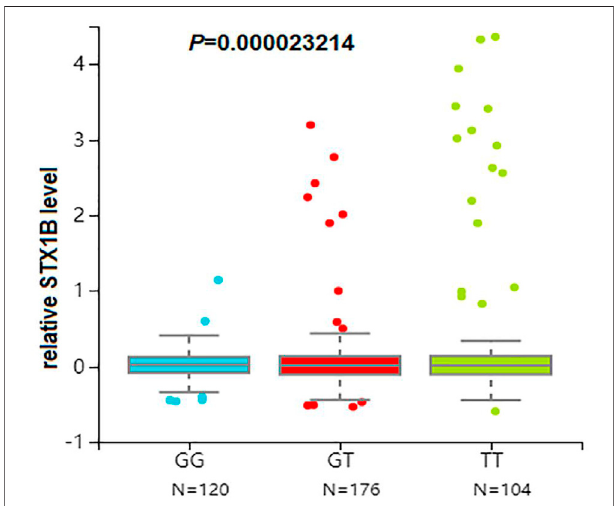
FIGURE 3 | The rs140820592 is an eQTL in the dorsolateral prefrontal cortex. Data were retrieved from the brain tissue database Braincloud (http://